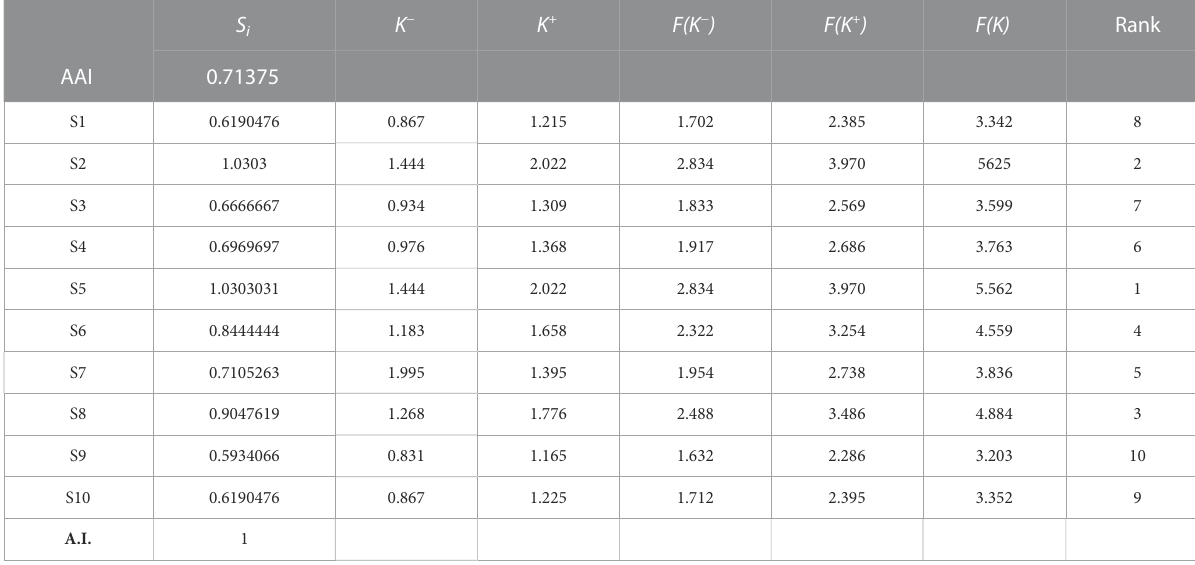
TABLE 7 Rank of solutions (Source: